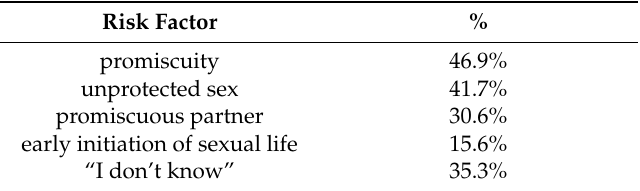
Table 3. Distribution of answers concerning risk factors for HPV